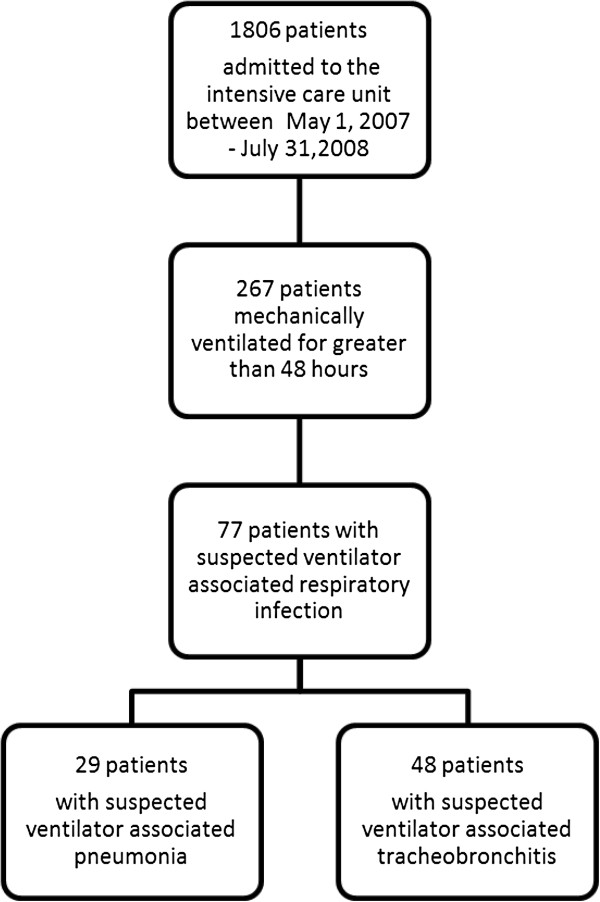
Patient flow. A flow diagram for patients at risk for suspected ventilator-associated pneumonia, and identification of patients with suspected ventilator-associated tracheobronchitis (sVAT) or suspected ventilator-associated pneumonia (sVAP), are shown.